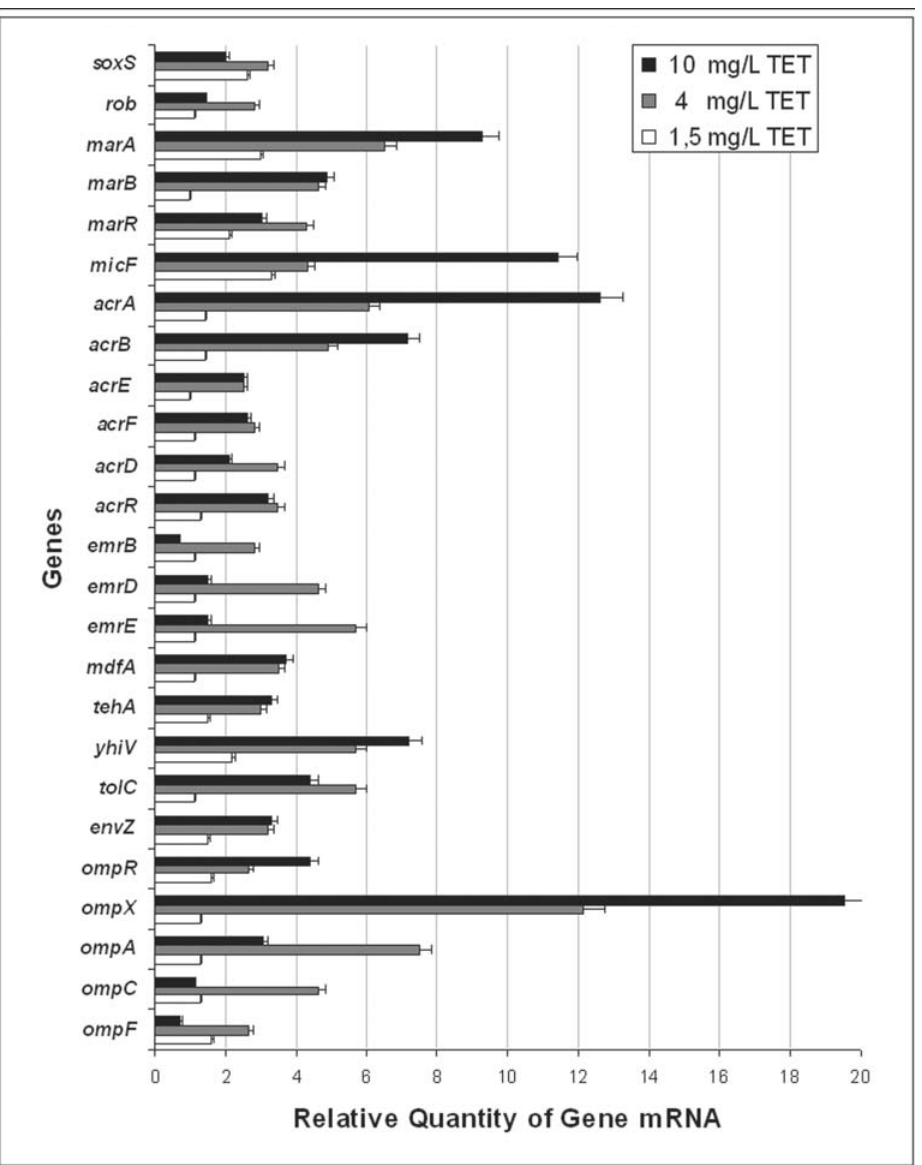
Figure 1. Relative expression of outer membrane proteins, regulators and inner membrane transporter genes . Data from three independent total mRNA extractions of E. coli AG100 physiologically adapted to increasing concentrations of TET compared to its parental non-induced strain grown in the absence of TET as described in Materials and Methods. A ratio of 1 corresponds to no alterations in expression compared with untreated control cells. Values were corrected for standard deviation